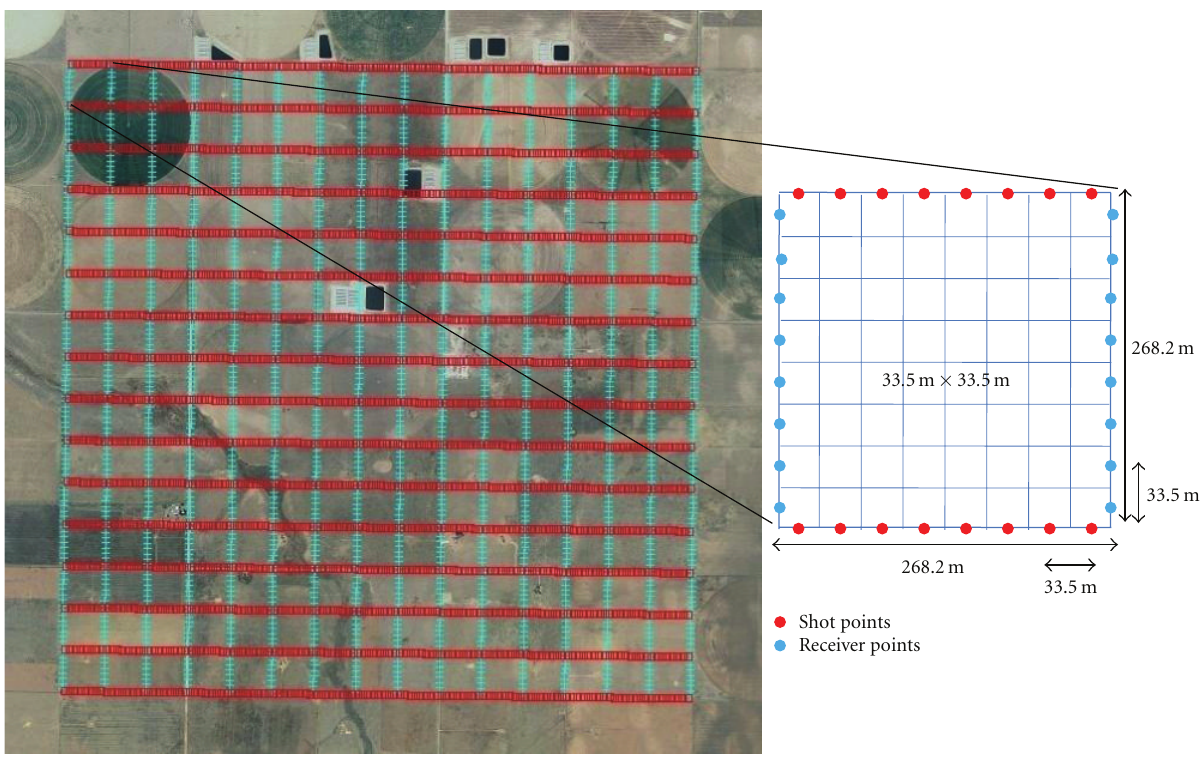
Figure 16: Acquisition parameters. Shot points are shown by red dots and receiver points are shown by blue dots. There are 16 shot lines in E-W direction and 16 receiver lines in N-S direction. Both shot and receivers point spacing is 33.5m, and the data is binned at 33.5m ×